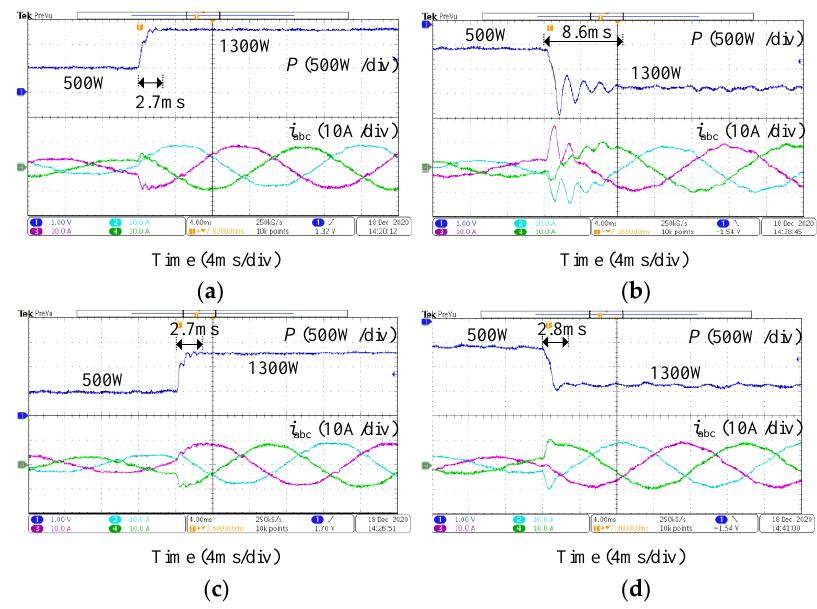
Figure 19. Experimental results as P changes, with U d = 100 V. ( a ) Conventional control under for- ward power flow. ( b ) Conventional control under reverse power flow. ( c ) IRSE control under for- ward power flow. ( d ) IRSE control under reverse power flow.